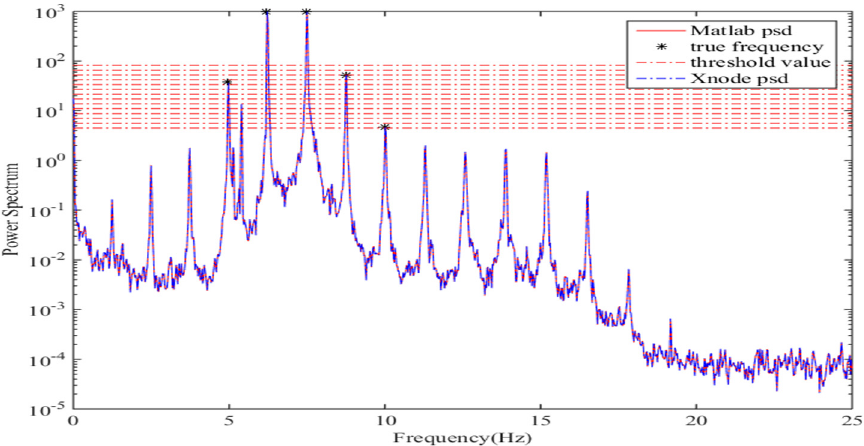
Figure 12. Power spectral density of cable #64 in Z-axis.